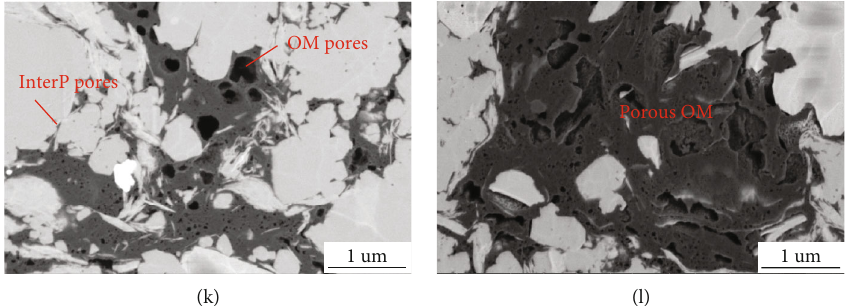
Figure 6: FE-SEM images of the shale samples from wellblock XN111. (a) OM pores, pyrite, and interP pores at the edges of mineral grains; (b) large OM particle with irregular and elliptical OM pores; (c) intercrystalline interP pores in pyrite framboids; (d) microfractures; (e) intraP pores with calcite grains; (f) OM pores and interP pores at the edge of a calcite grains; (g) interP pores at the edges of mineral grains, OM pores, and intercrystalline interP pores in clay particles; (h) fl uid inclusion intraP pores within brittle minerals and OM pores in OM grains; (i) cleavage-sheet intraP pores within clay particles and OM pores; (j) intercrystalline interP pores in pyrite framboids, microfractures and OM particle with irregular and elliptical OM pores; (k) OM pores and interP pores at the edges of mineral grains; (l) porous OM